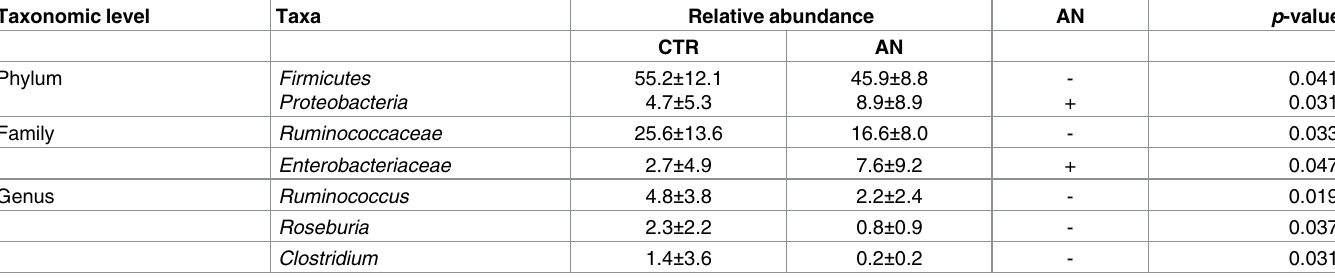
Table 3. Taxa significantly increased(+) or decreased(-) in abundance in anorexia nervosa subjects.